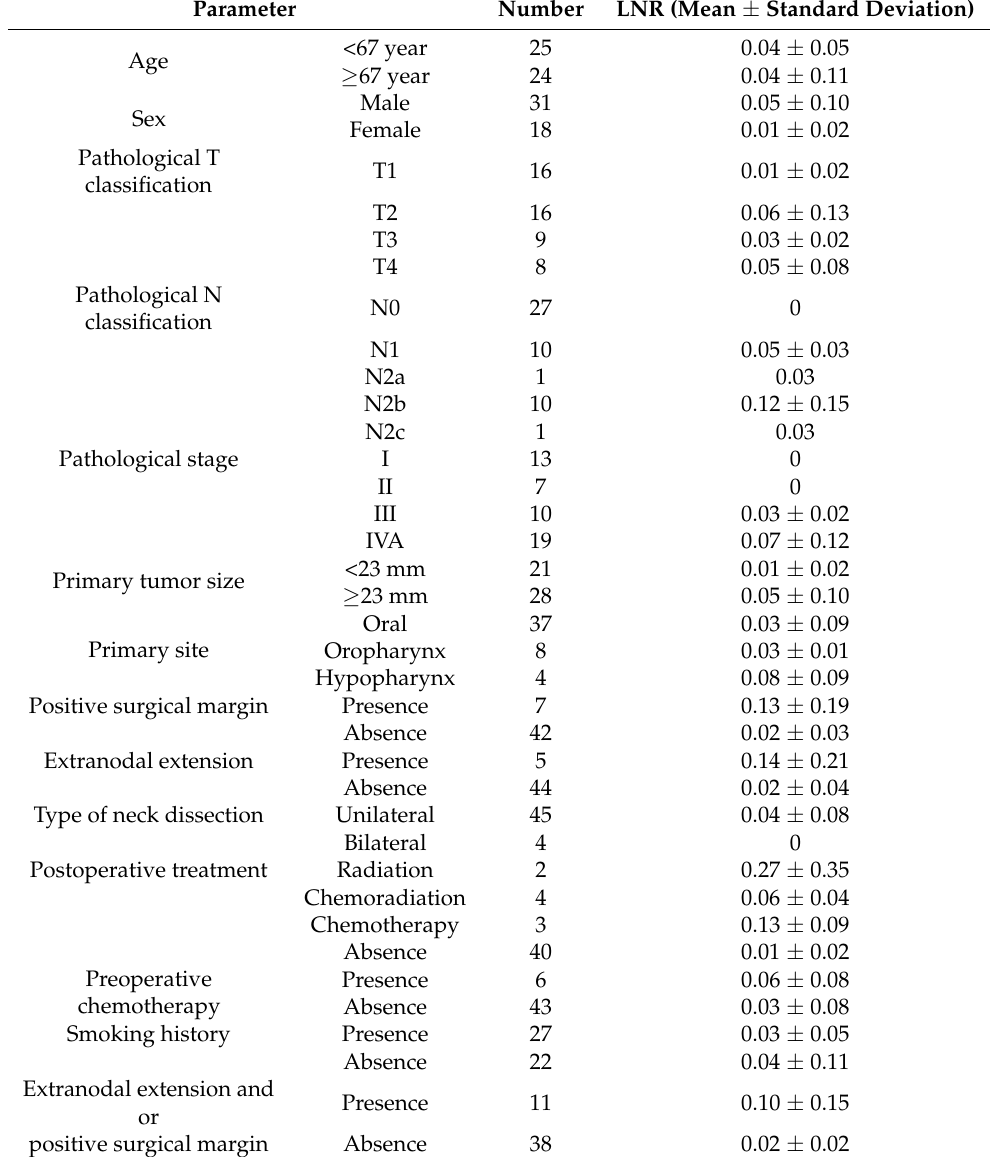
Table 1. Association between clinicopathologic parameters and